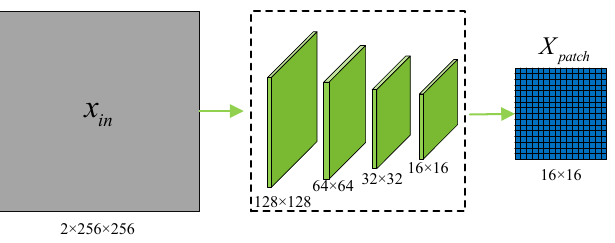
Figure 7. The structure of the discriminator network module of the proposed